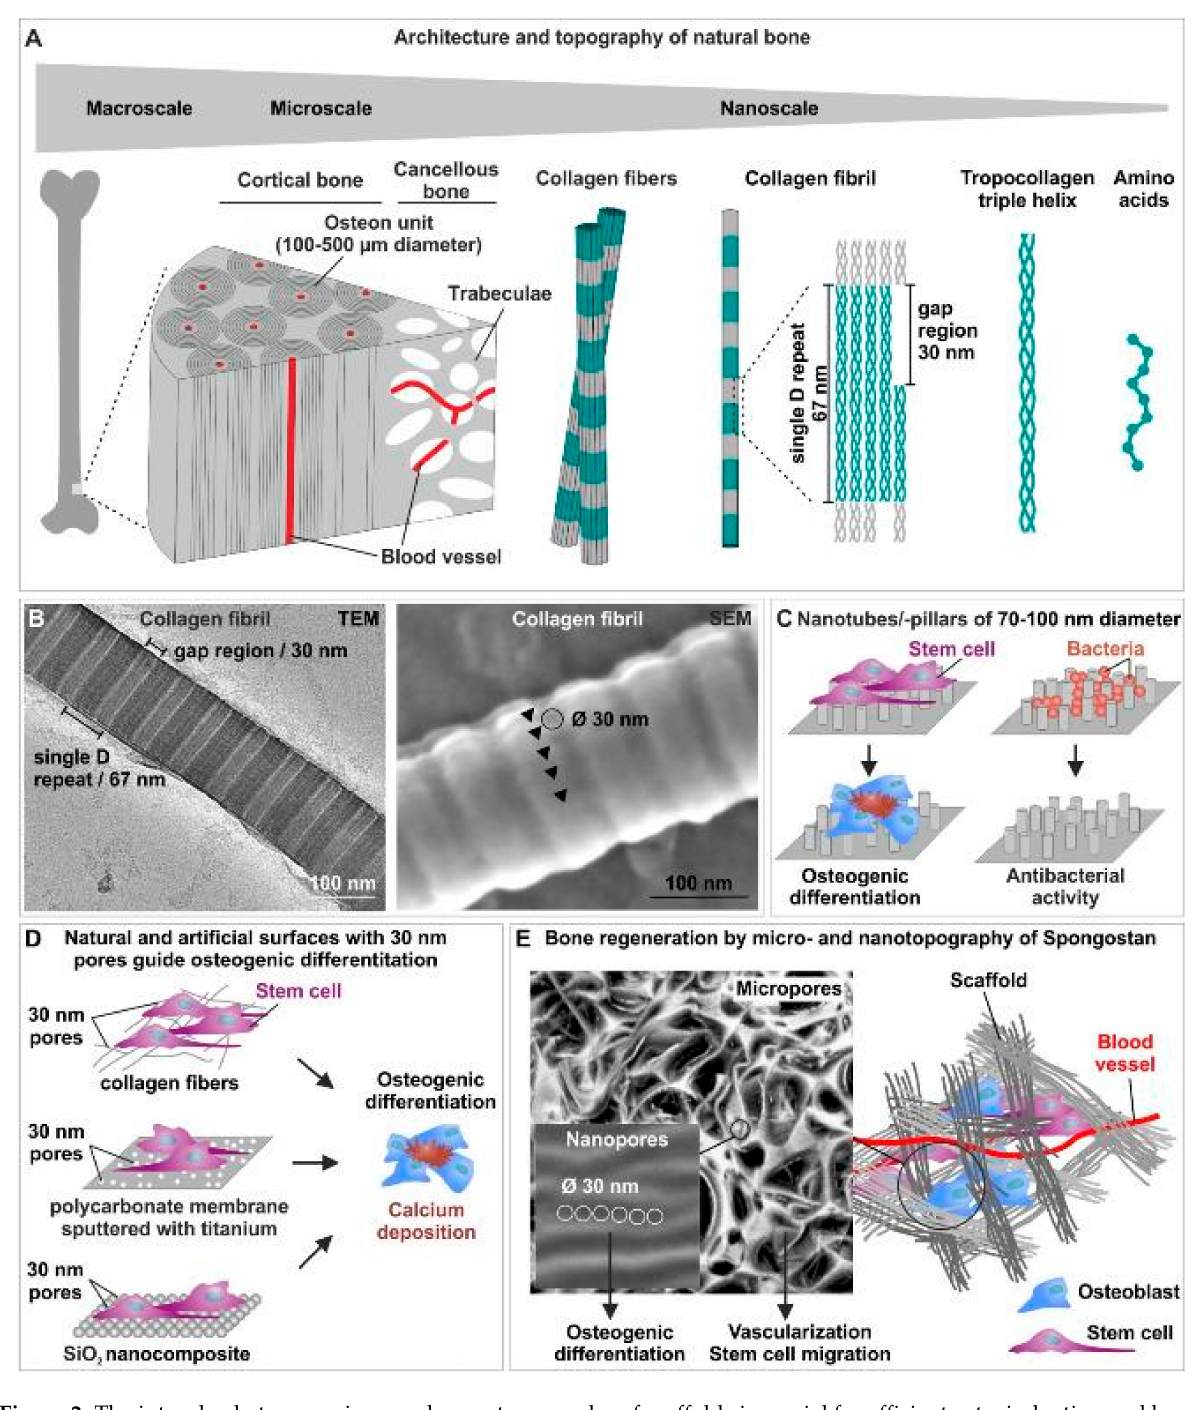
Figure 2. The interplay between micro- and nano-topography of scaffolds is crucial for efficient osteoinduction and bone regeneration. ( A ) Schematic view of the architecture and topography of natural bone from the macro- to the micro- and the nanoscale. ( B ) Transmission electron microscopic (TEM) and scanning electron microscopic (SEM) images of nanopores with 31.93 ± 0.97 nm diameter on the surface of collagen type I fibers [86]. ( C ) Nanotubes or nanopillars with a a diameter of 70–100 nm drive osteogenic differentiation of stem cells and possess a highly efficient antibacterial activity [89,90,92]. ( D ) 30 nm pores on collagen type I fibers [86], a polycarbonate membrane sputtered with titanium [97] or a SiO 2 nanocomposite [86] efficiently guide osteogenic differentiation of human stem cells. ( E ) Micropores present in Spongostan allow migration of stem cells and vascularization, while osteoinductive nanopores of 30 nm diameter guide the stem cells into the osteogenic fate [87]. Parts of this figure are taken or modified from [86] (License: CC BY-NC-ND 4.0) [87] (License: Creative Common CC BY